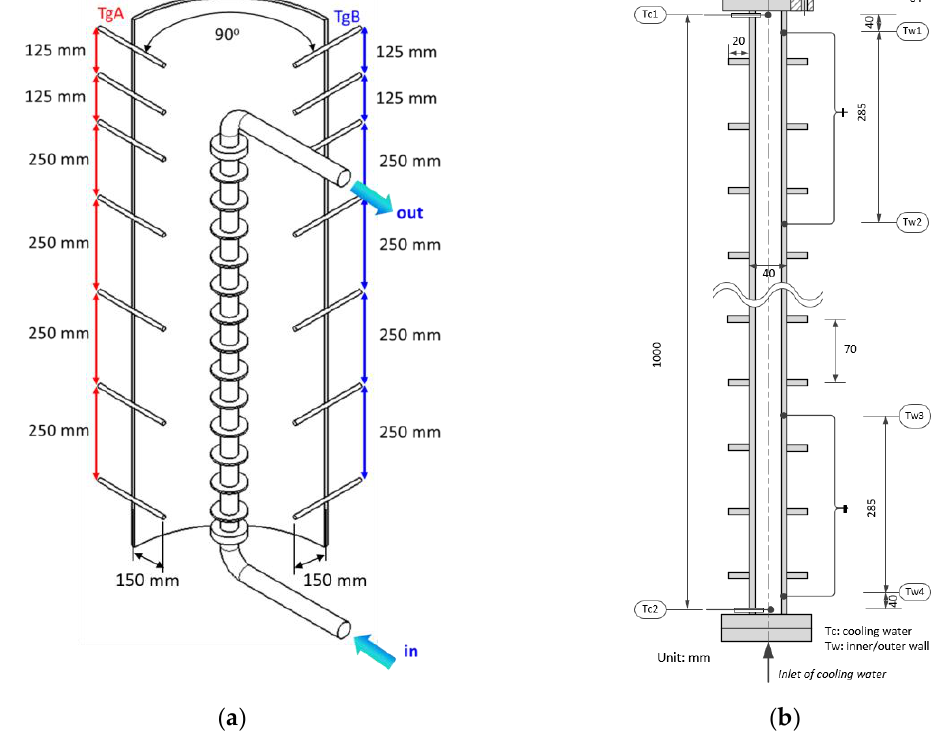
Figure 7. Locations of the temperature measurement. ( a ) Thermocouples in the chamber; ( b ) Thermocouples on the finned tube.